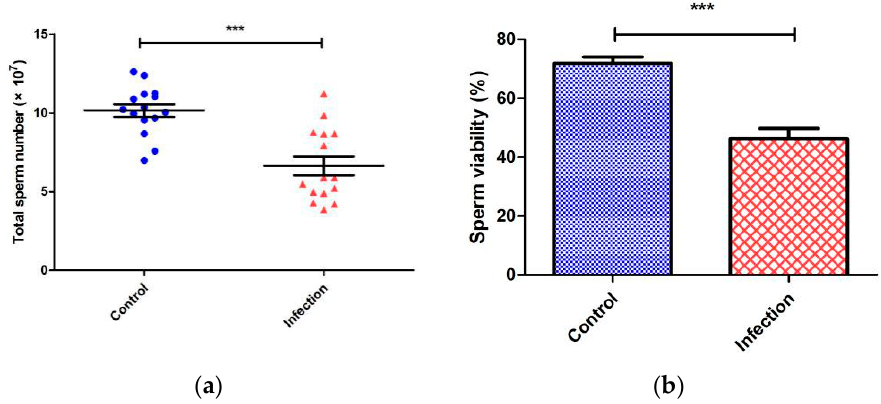
Figure 1. Statistical results of sperm quality parameters during microscopy ( t -test). ( a ) Scatter plot of total sperm number, control group, and infection group gradually decreased. The whiskers were upper quartile, the median, and lower quartile. The whiskers of the control group were 9.55 × 10 7 , 10.22 × 10 7 , 11.2 × 10 7 . The whiskers of the infection group were 4.89 × 10 7 , 5.88 × 10 7 , 8.68 × 10 7 . ( b ) The histogram of sperm viability indicates that control group and infection group were 71.92% ± 2.11% and 46.28% ± 3.497% (mean ± SEM), respectively. (*** p < 0.0001). Error bars represent SEM.